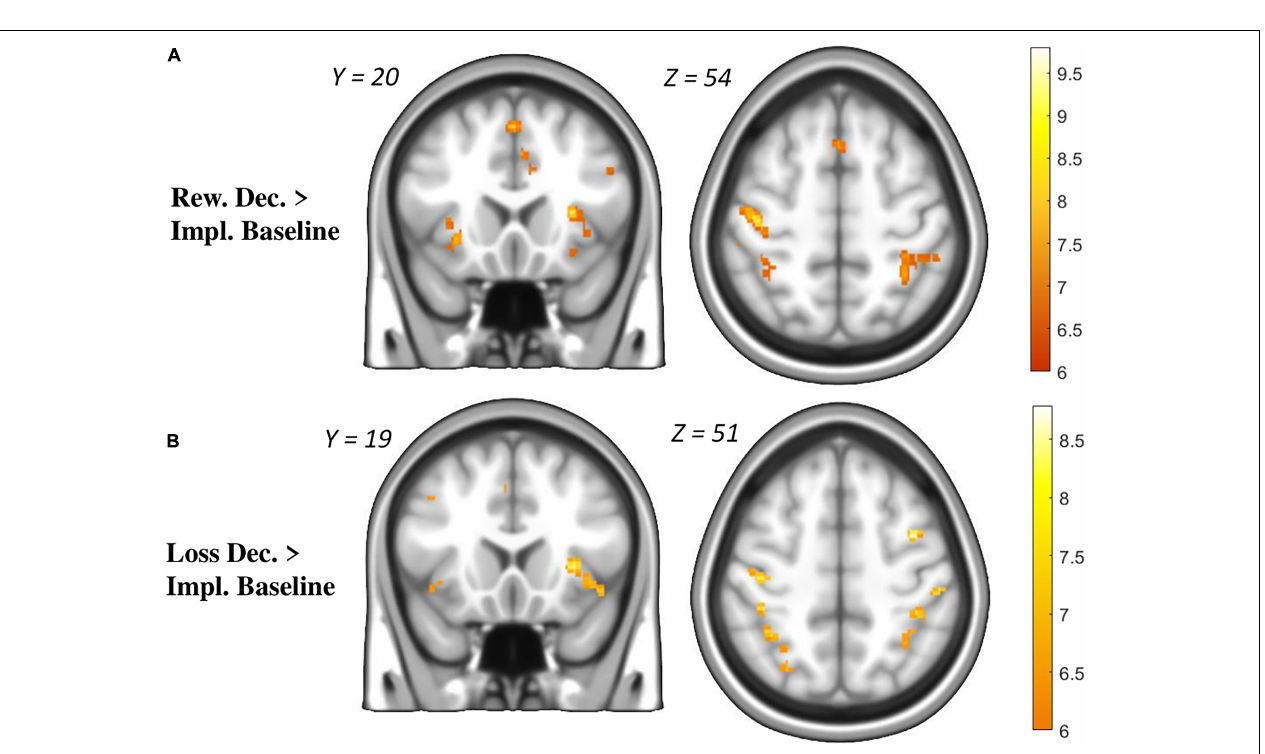
FIGURE 3 | Brain activation during the decision phase (intertemporal choice task). (A) : Reward Decision Phase > Implicit Baseline (B) : Loss Decision Phase > Implicit Baseline. Results displayed at p < 0.5 FWE-corrected for multiple testing.